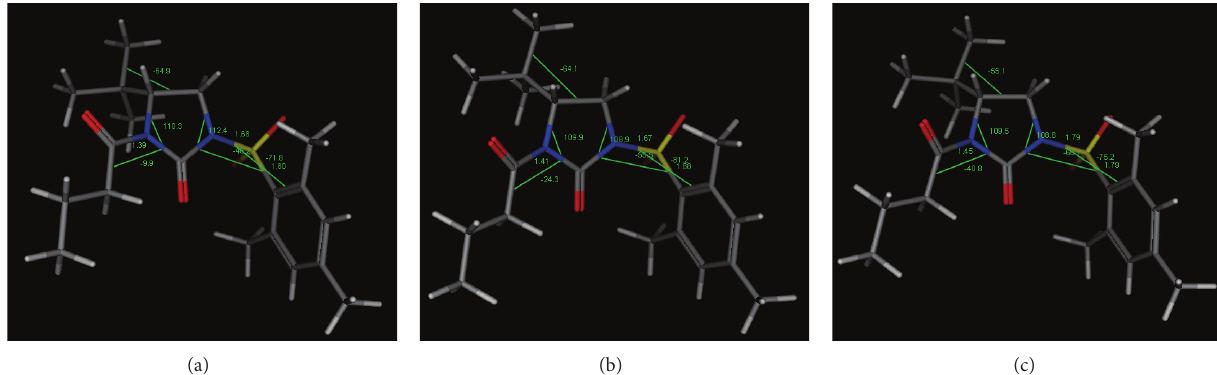
Figure 5: Most stable energy minimum ( conformer - A ) as energy optimized with MM+ force field (a) and both AM1 (b) and PM3 (c) semiempirical molecular orbital methods showing some geometrical parameters such as bond length, bond angle, and dihedral angle.